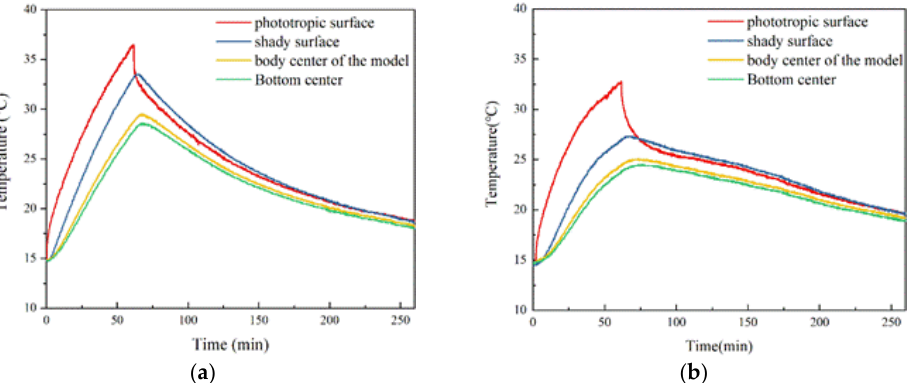
Figure 17. Temperature changes at each point of the cube model. ( a ) Basalt aggregate concrete cube model. ( b ) Phase change aggregate concrete cube model.